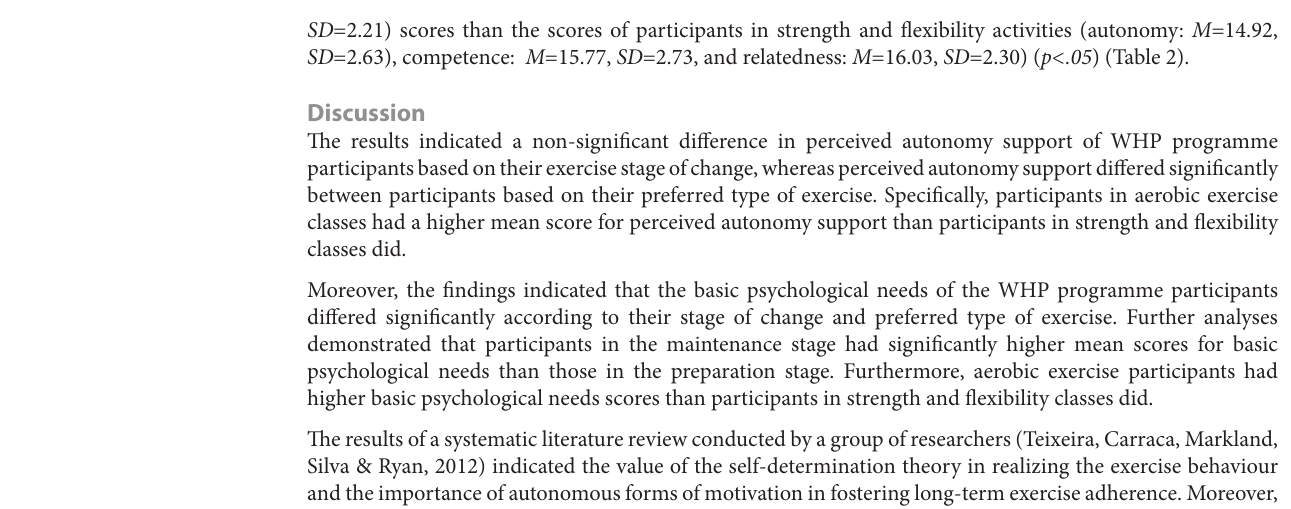
Note: *Significant difference (p